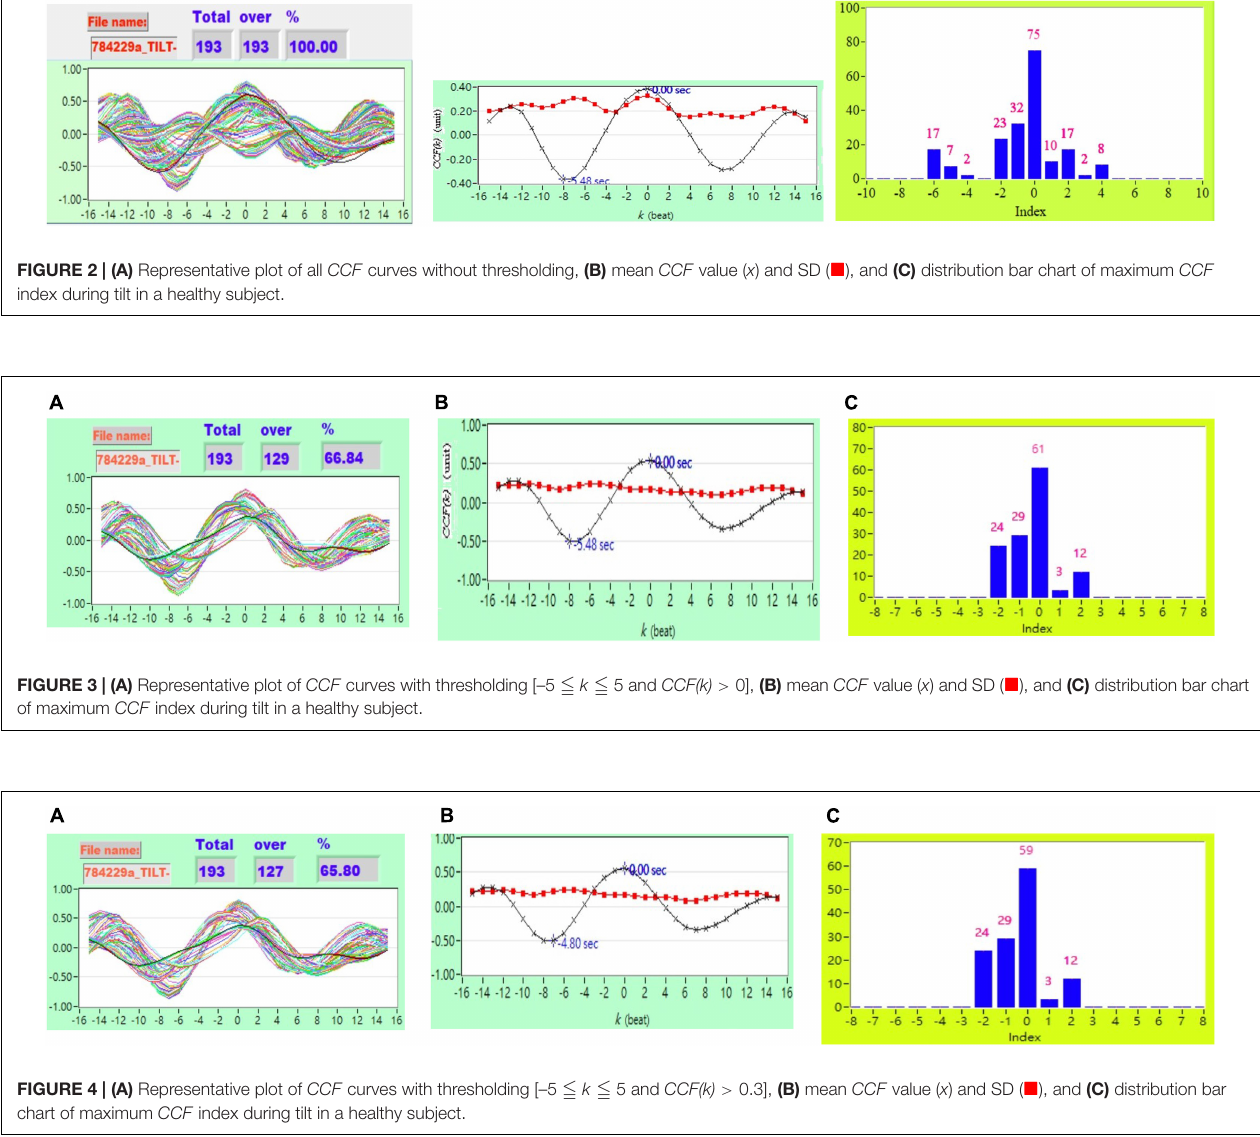
Frontiers in Neuroscience |